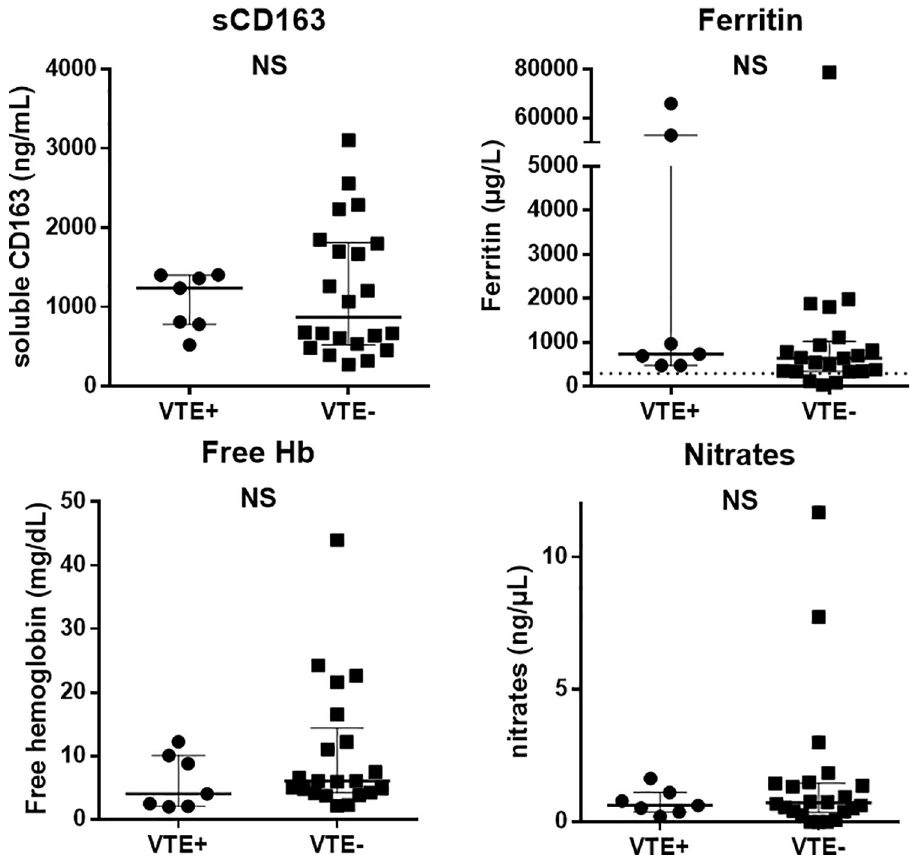
Fig 2. Comparison of serum levels of soluble CD163, ferritin, free hemoglobin and nitrates between patients with venous thromboembolism (VTE+) and those without (VTE-). Results are given by medians [interquartile range (IQR)]. NS: